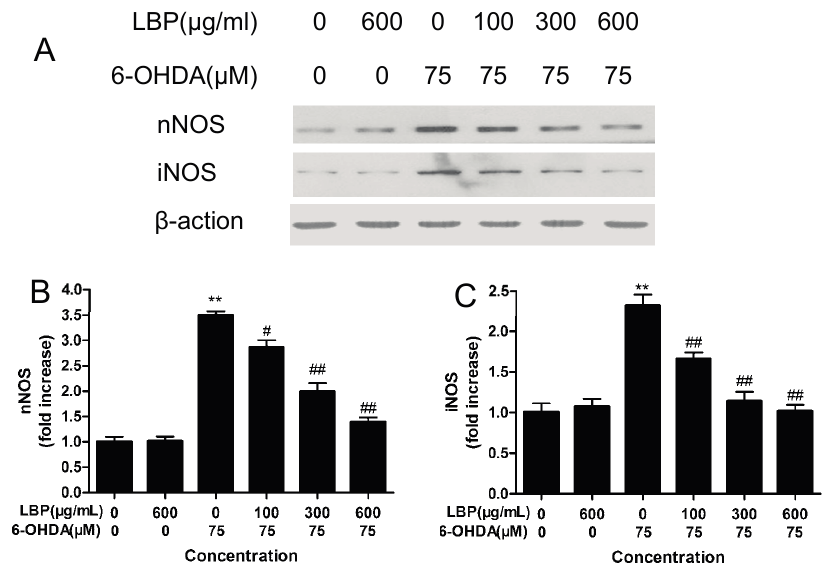
Figure 6. Effect of LBP and 6-OHDA on the expression of nNOS and iNOS. PC12 cells were exposed to 6-OHDA (75 μ M) with or without various concentrations of LBP for 24 h, and the nNOS and iNOS were detected by western blot ( A ); The protein levels and date analysis for nNOS ( B ) and iNOS ( C ); Data obtained from quantitative densitometry were presented as mean ± SD for three independent experiments. ** p < 0.01 compared with untreated control cells; # p < 0.05, ## p < 0.01 compared with 6-OHDA-treated